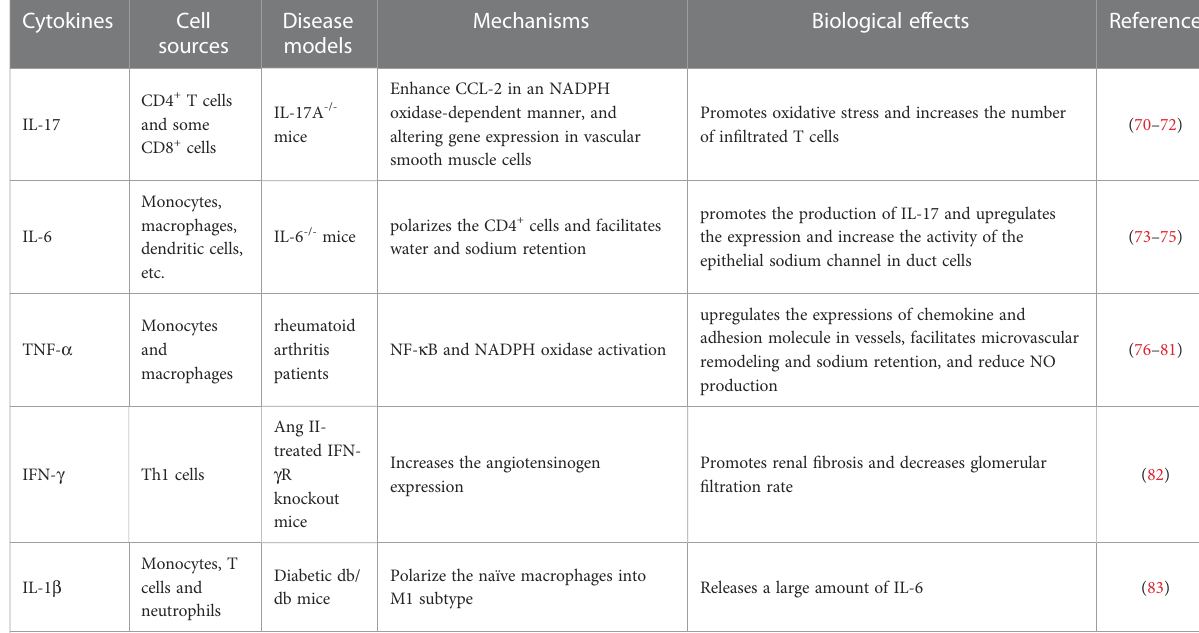
TABLE 1 Examples of in fl ammatory cytokines involved in